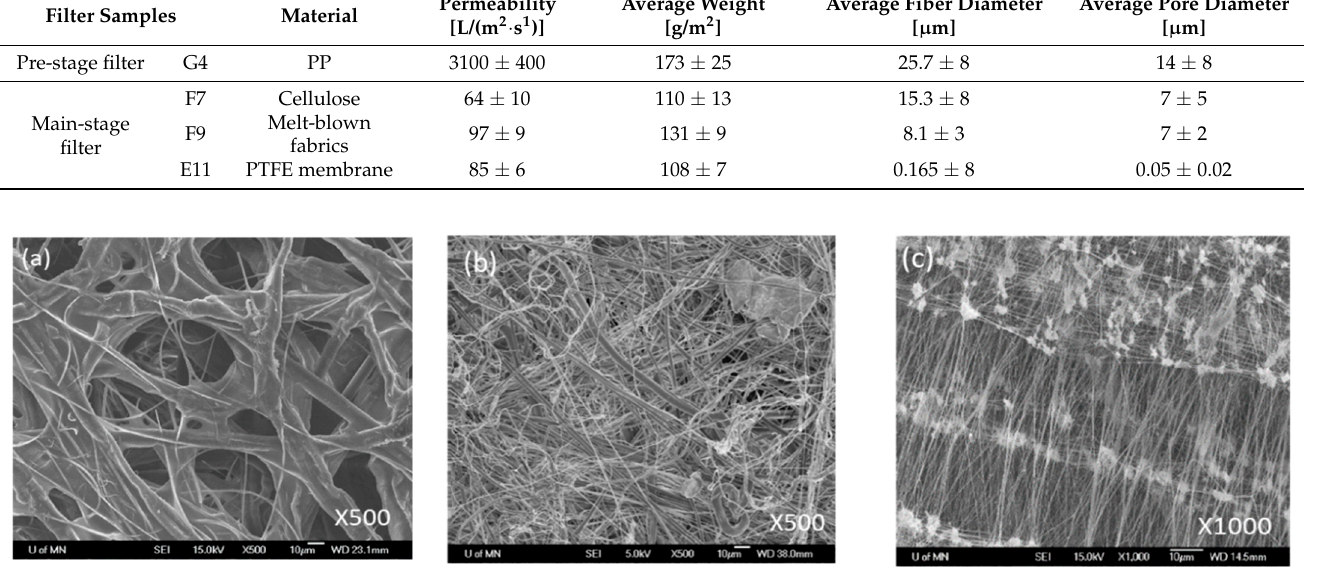
Figure 1. SEM image view for filter samples: ( a ) F7 cellulose filter, ( b ) F9 melt-blown filter, ( c ) E11 PTFE membrane-coated filter.